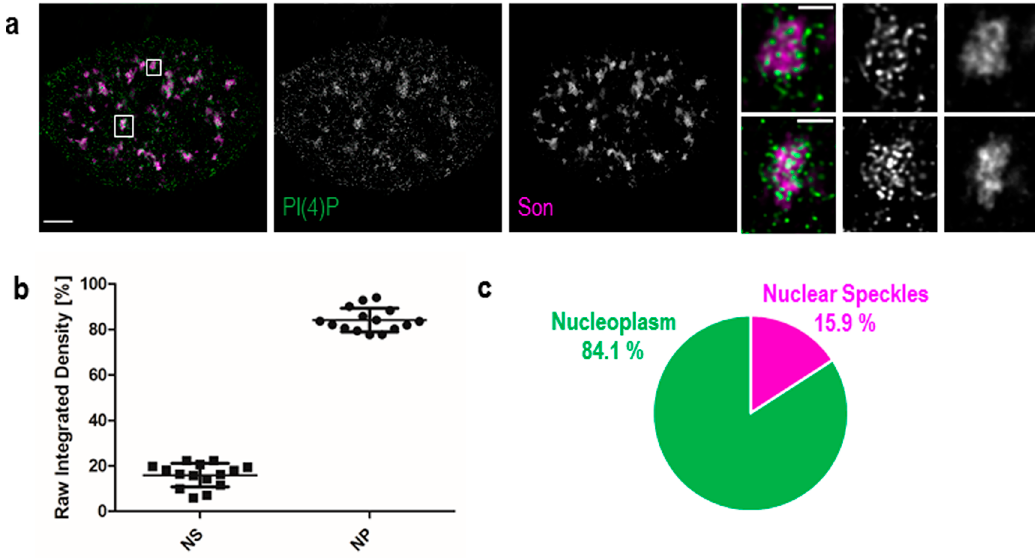
Figure 2. PI(4)P also localises to the nuclear speckles. Beside the nuclear membrane, the nuclear lamina, the nucleoli and nucleoplasmic foci, super-resolution STED microscopy revealed the localisation of PI(4)P in the nuclear speckles. ( a ) Co-localisation of PI(4)P with the Son protein, a marker of the nuclear speckles. PI(4)P is enriched inside and at the edges of nuclear speckles. Scale bar: 5 µ m, insets 1 µ m. ( b ) Percentage of PI(4)P signal in the nuclear speckles and the nucleoplasm per nucleus. Nearly 16% of the nuclear PI(4)P signal comes from the nuclear speckles. The graph was made in the GraphPad Prism program; data are shown as the mean with SD. NS—nuclear speckles, NP—nucleoplasm. ( c ) Pie chart representation of the results in b .